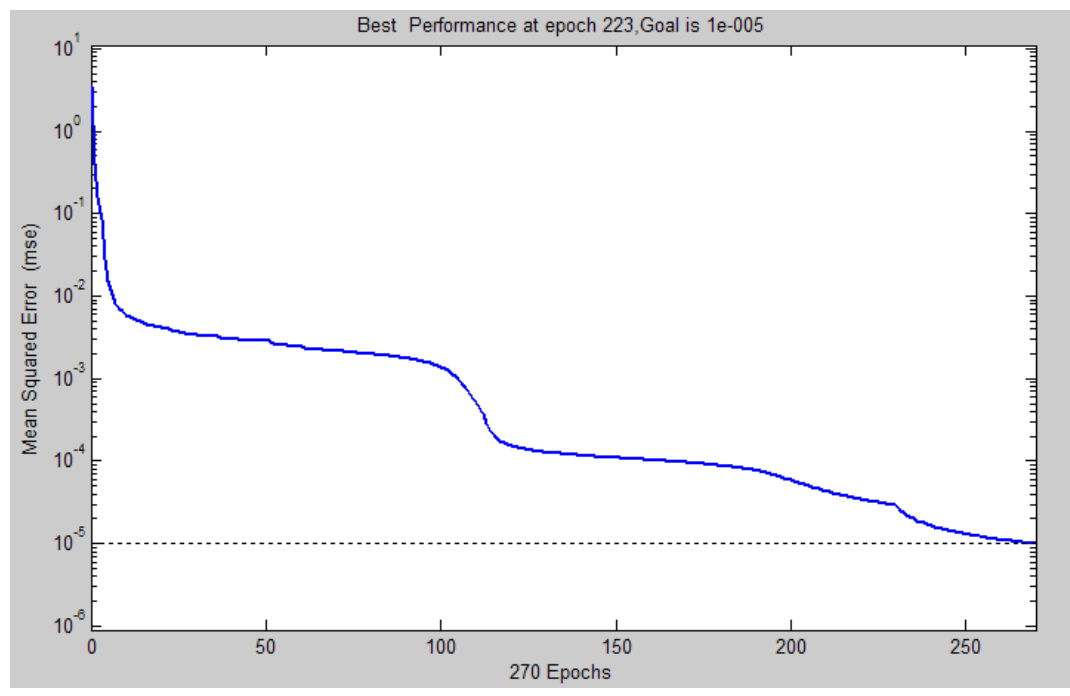
Figure 1. Training of the